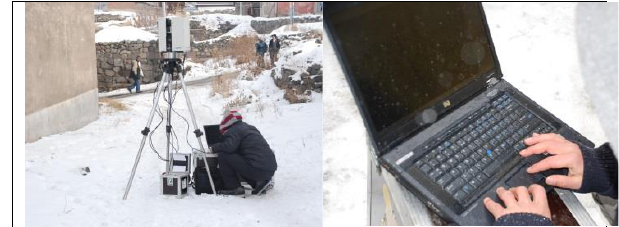
Figure 6. Field Works